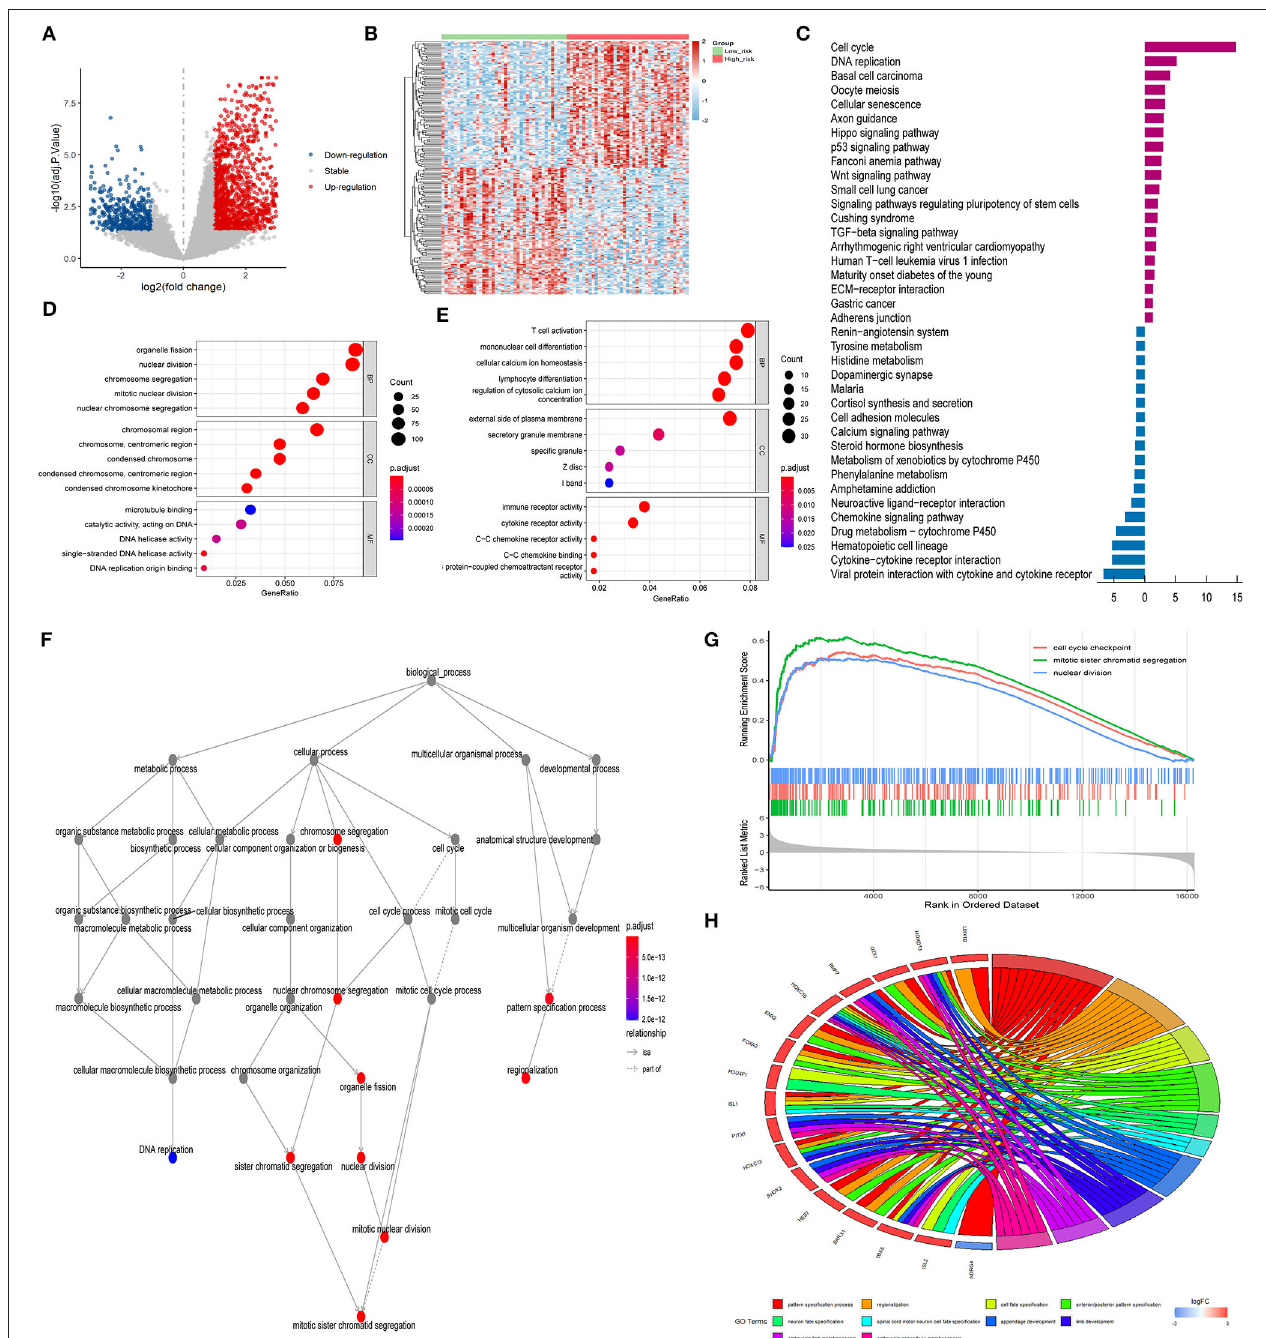
FIGURE 8 | GO and KEGG analysis. (A) Volcano plots indicating up-expressed and down-expressed genes between different risk groups in ACC; (B) Hierarchical clustering analysis of genes between different risk groups in ACC; (C) KEGG analysis of DEGs between different risk groups in ACC (dark purple represented up-regulation; blue represented down-regulation); (D) GO analysis of up-regulated DEGs between different risk groups in ACC; (E) GO analysis of down-regulated DEGs between different risk groups in ACC; (F) Interactive relationship between enriched BP pathways; (G) GSVA enrichment analysis; (H) Chord diagram of GO biological terms for DEGs with the top 100 largest fold change. ACC, adrenocortical carcinoma; GO, Gene Ontology; KEGG, Kyoto Encyclopedia of Genes and Genomes; DEG, differentially expressed gene; BP, biological process; MF, molecular function; CC, cellular component; GSVA, Gene Set Variation Analysis.